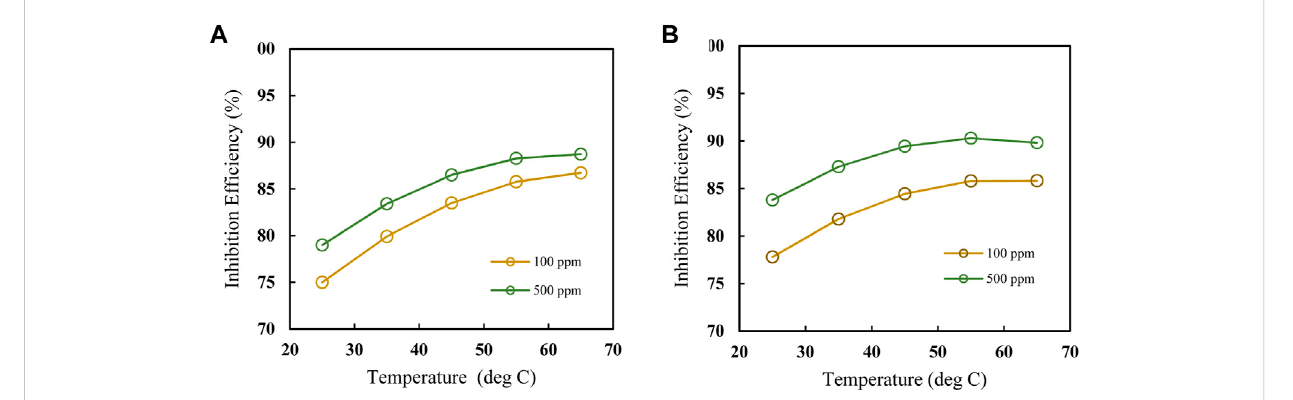
FIGURE 12 Effect of temperature on IE at 100 and 500 ppm at (A) 4 h and (B) 24 h.